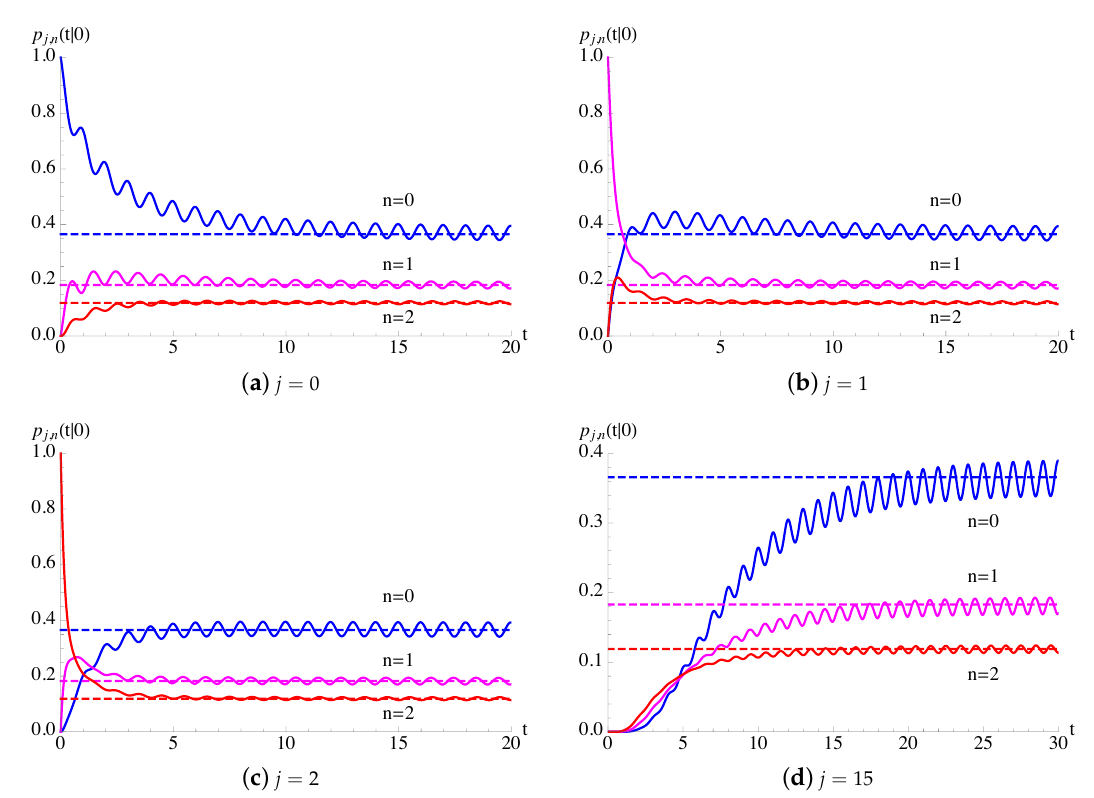
Figure 2. For the NHBDI process of Figure 1, the probabilities p j , n ( t | 0 ) are plotted as function of t for λ = 0.8, µ = 1.0, ν = 0.5, a = 0.9, Q = 1.0 with n = 0,1,2. The dashed lines indicate the asymptotic probabilities q 0 , q 1 , q 2 , given in (23), related to HBDI process.